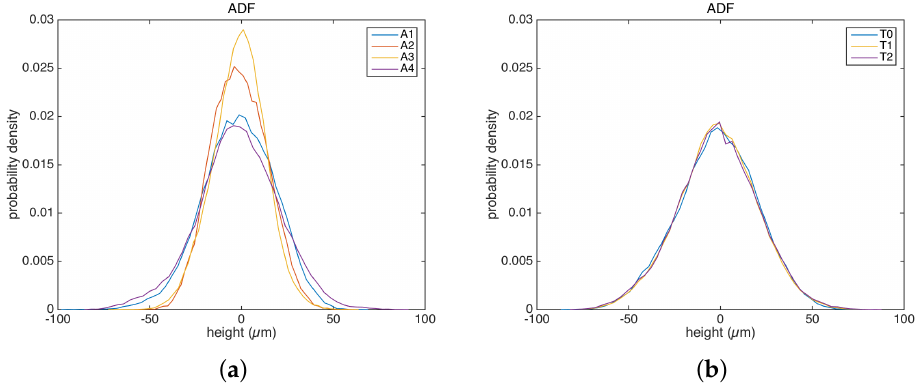
Figure 7. Probability density function of the heights: ( a ) multiple ROIs of red lake. ( b ) Single ROI of